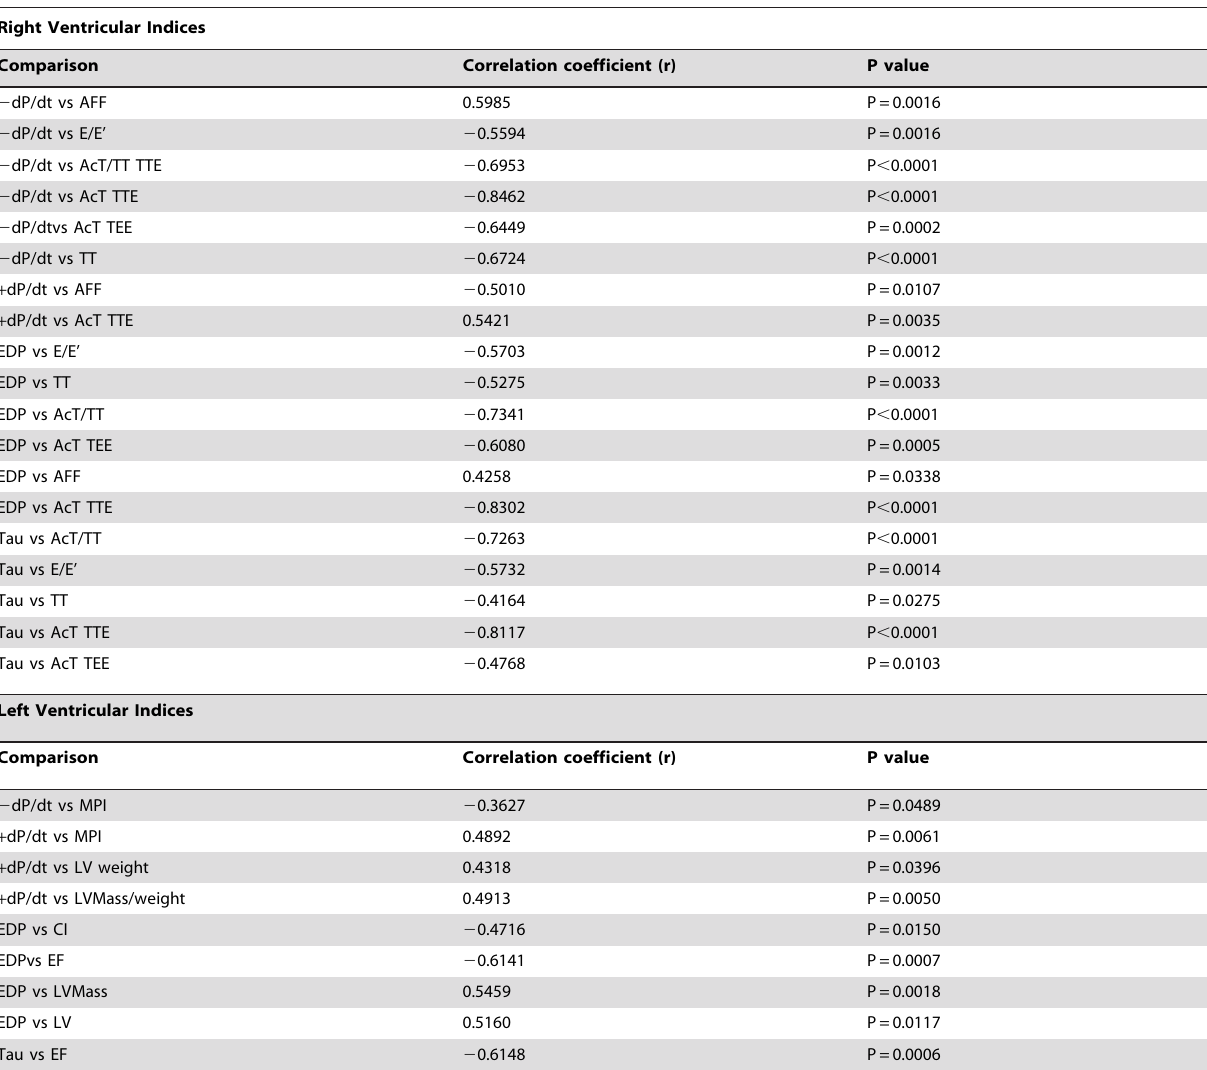
Table 6. Correlations between invasive and noninvasive data in all animals.